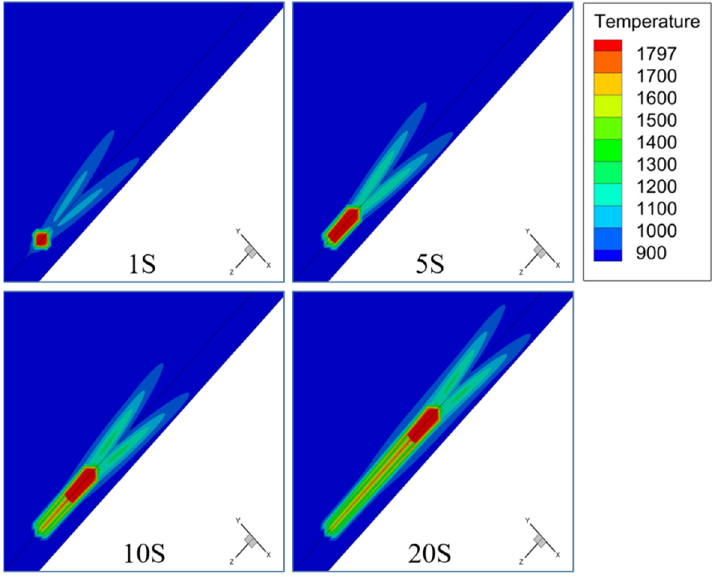
Figure 13. Temperature diagram of the upper and right surfaces of casting slab at different times.